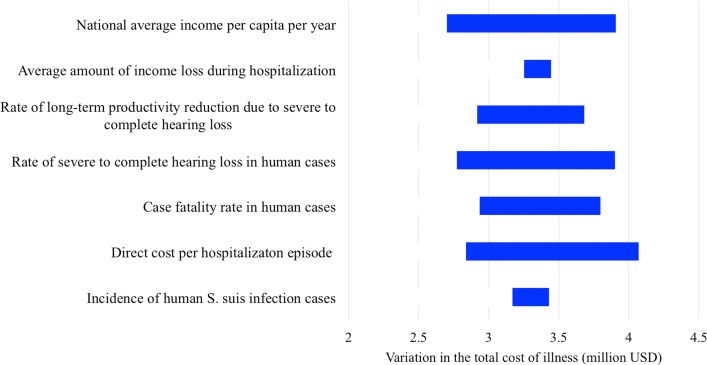
One-way sensitivity analysis showing the effect of changing the expected value in each parameter on the total cost of human S. suis infection in Viet Nam in 2011.